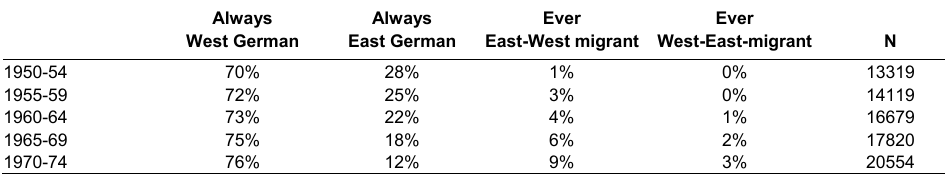
Table A1 : Cases by region, row %